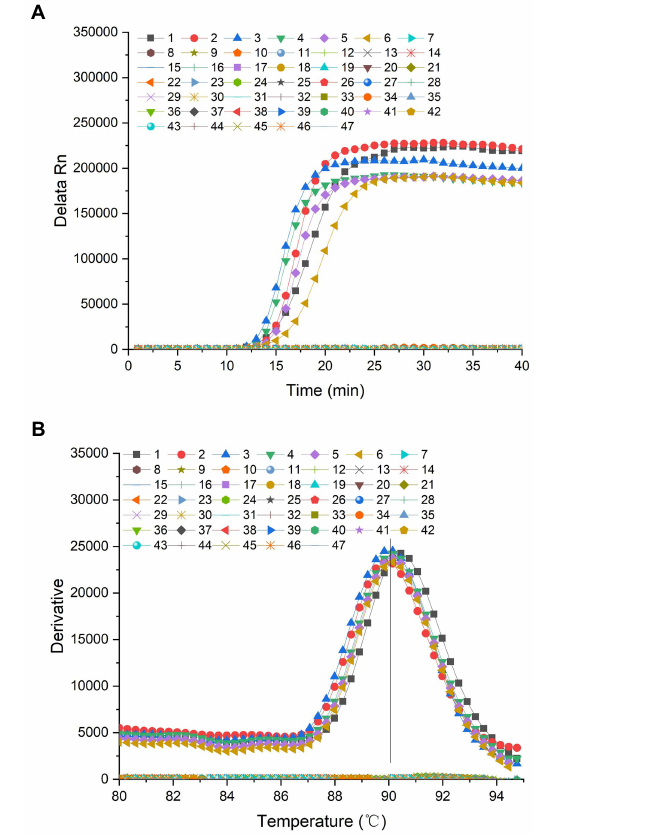
FIGURE 3 (A) Amplification curve of the specificity of the aprX gene of Pseudomonas lurida . 1: P. lurida CICC22026, 2: P. lurida CICC22027, 3: Pseudomonas fluorescens ATCC13525, 4: P. fluorescens CICC23250, 5: P. fluorescens CICC23251, 6: P. fluorescens CICC23254, 7: Pseudomonas